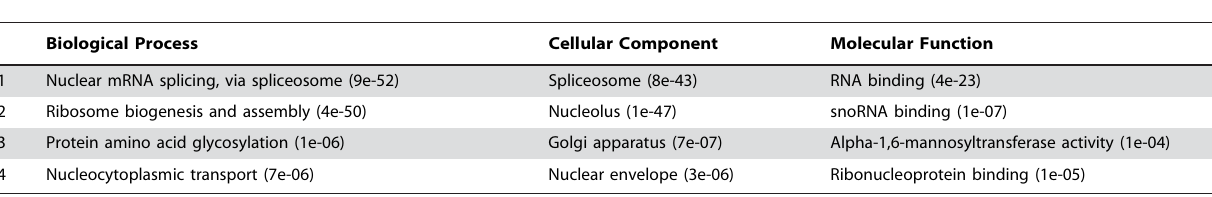
Table 3. GO enrichment of predicted new complexes not in